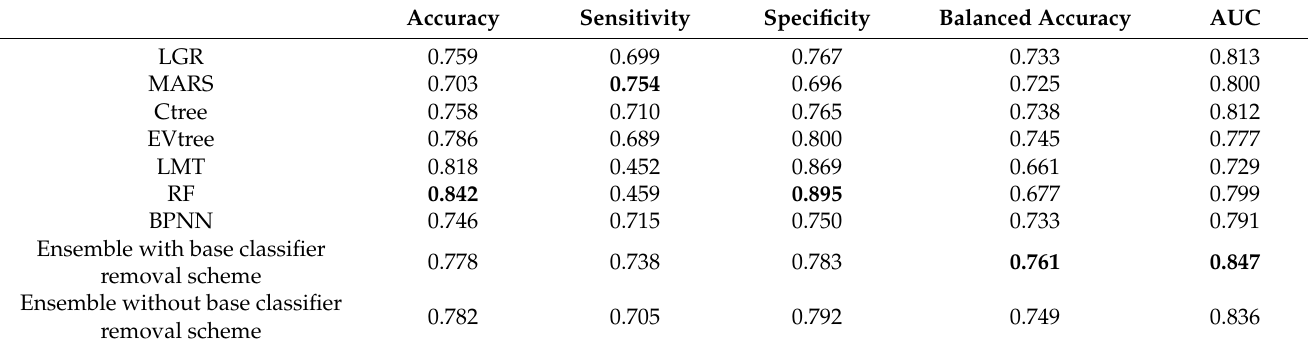
Table 1. Model performance of base classifiers or meta-classifiers for testing dataset.